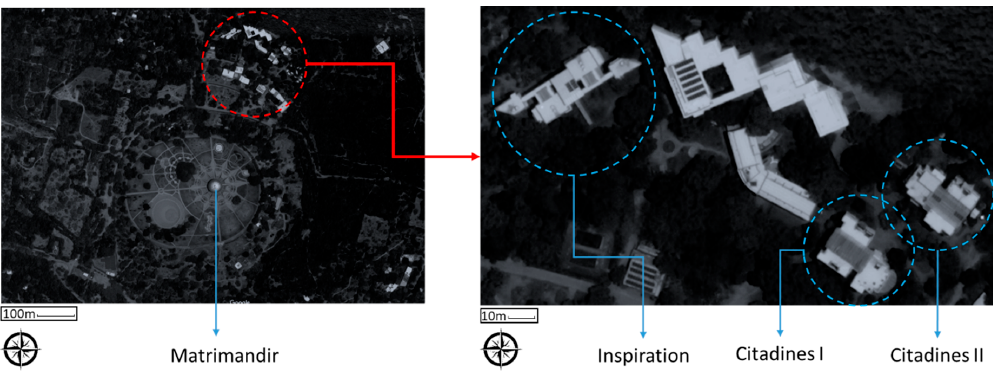
Figure 1. Monitored buildings (Auroville); source [33].